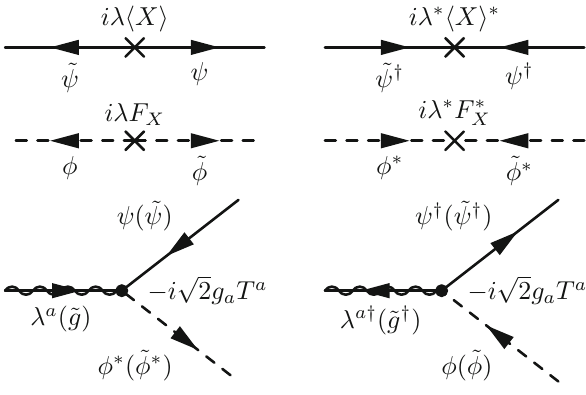
Fig. 1 Messenger coupling vertices related to the gaugino mass